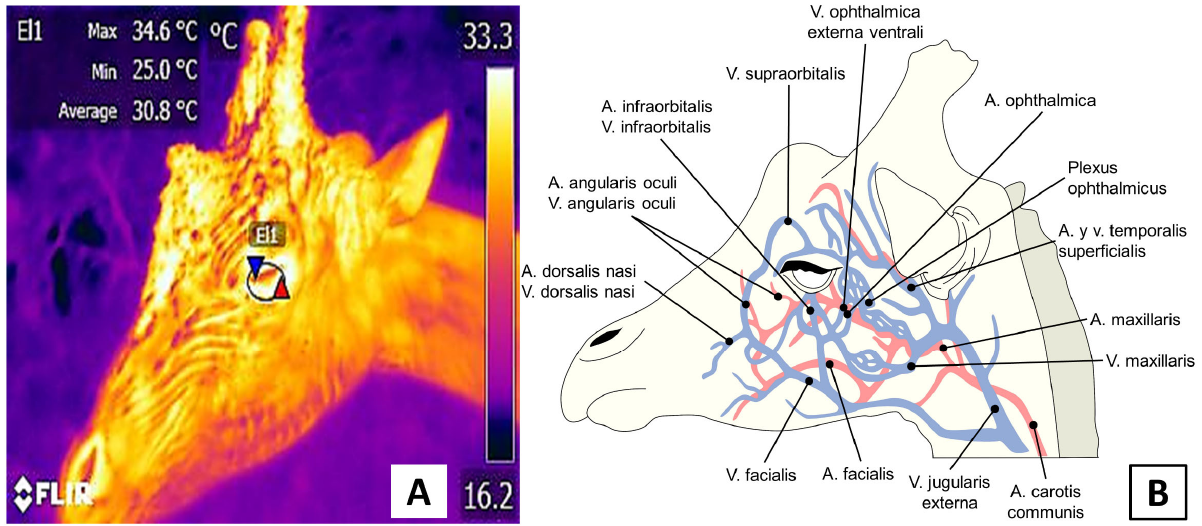
Figure 4. Depiction of the ocular window of a giraffe ( Giraffa camelopardis ). ( A ). A circle, approximately 3 cm in diameter encompasses the periocular region and a small portion of the eyelid. ( B ). Blood irrigation in this window comes from the supraorbital and infraorbital arteries, whose sympathetic innervation proceeds from branches of the facial nerve.